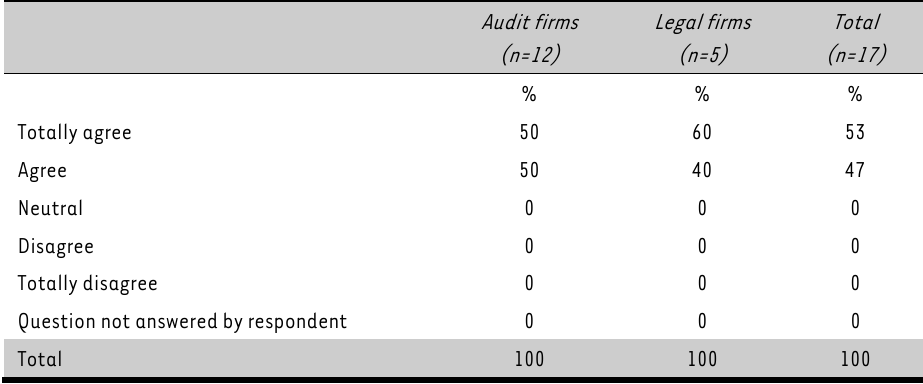
TABLE 6: Results of question 4.4.4